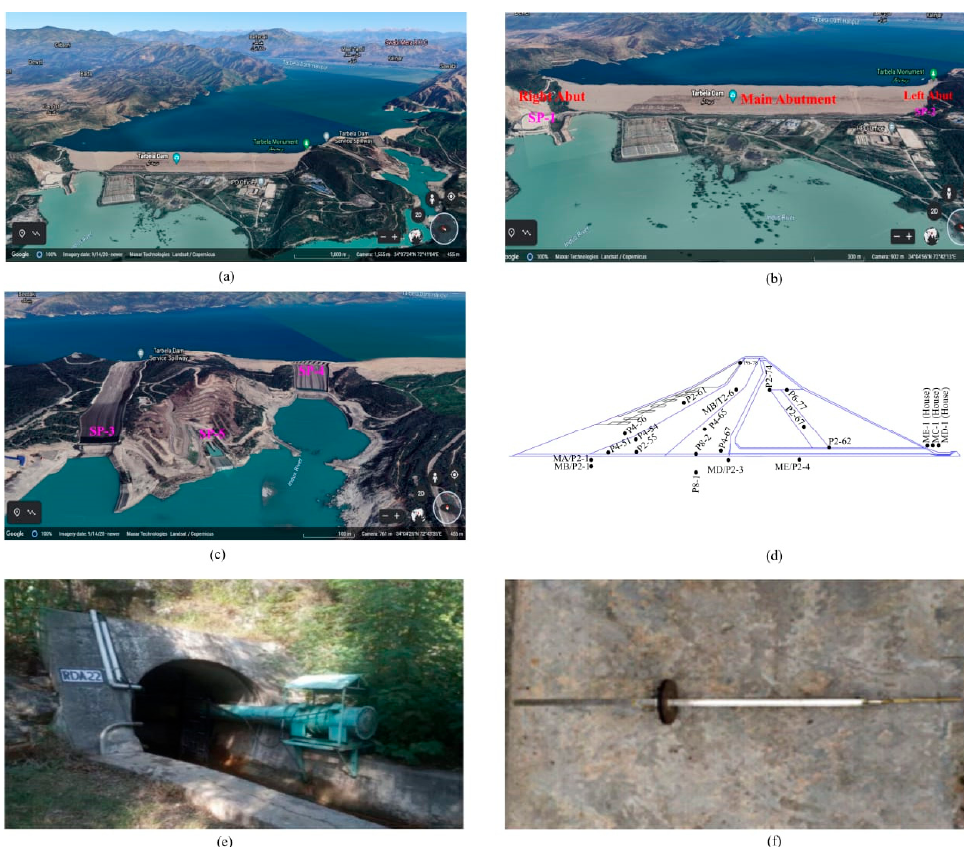
Figure 2. ( a ) overview of Tarbela dam; ( b ) the seepage location of left and right abutment; ( c ) the seepage location of auxiliary, service spillway, and seepage at auxiliary dam foundation; ( d ) the cross-section of Tarbela dam with audit points; ( e ) the audit for seepage water in Tarbela dam; and ( f ) the vernier gauge instrument used for seepage measurement in the Tarbela dam.